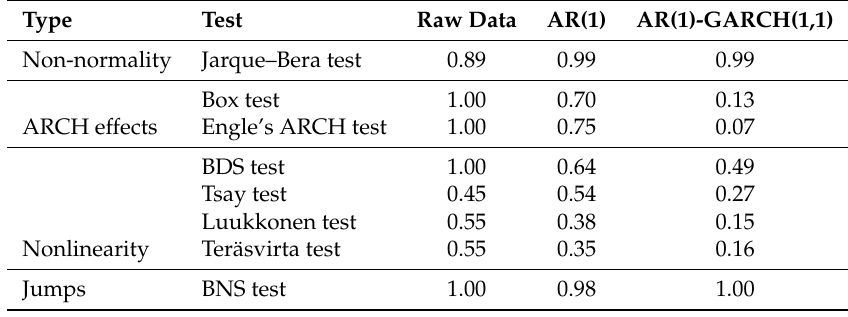
Table 2. Evaluation of 41,069 sets of cointegration residuals between the DAX 30 constituents identified on 249 trading days in 2014. Subject to testing are the raw data, the residuals after AR(1)-filtration and the residuals after AR(1)-GARCH(1,1)-filtration. Depicted is the share of tests with a p -value less than